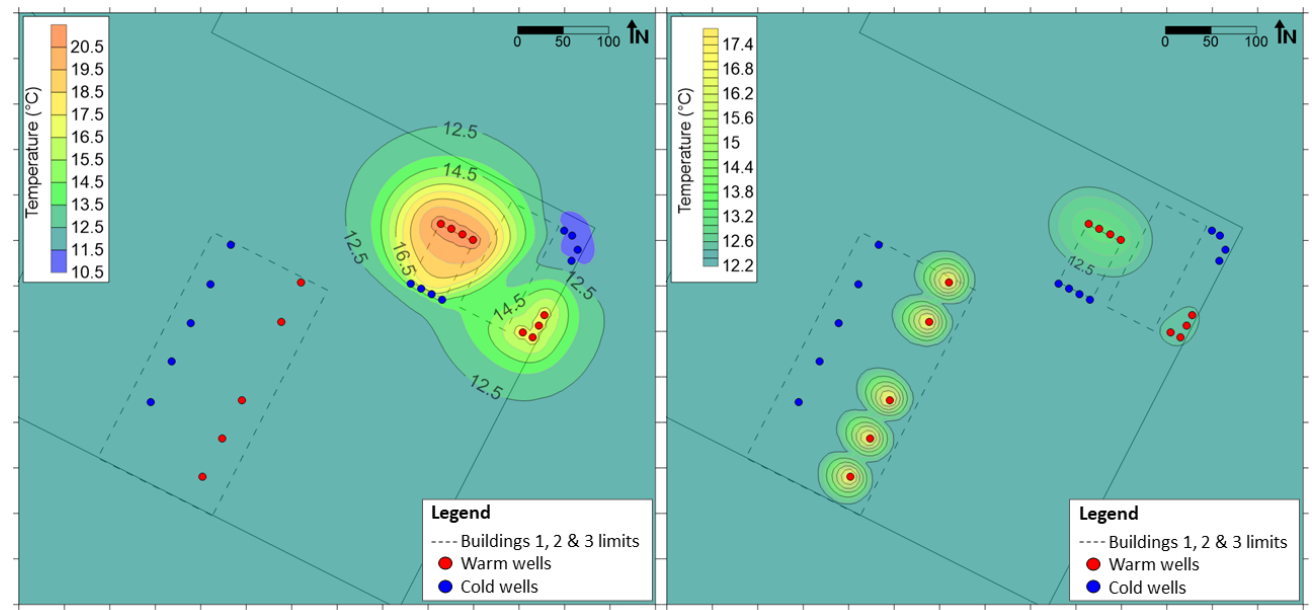
Figure 9. Simulated heat and cold plumes for 1 October 2020 (end of the first cooling period of Building 3) in the shallow ( left ) and the deep ( right ) aquifer.